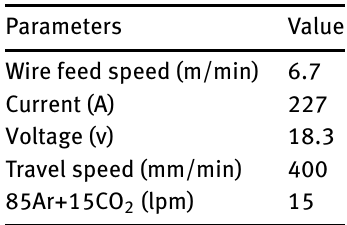
Table 3: GMAW-WAAM process parameters used to fabricate the component.